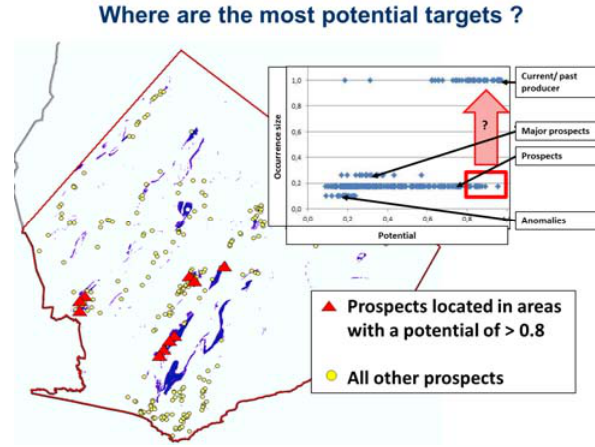
Figure 9. Evaluation of prospects with regard to their potential High potential prospects can clearly be separated from prospects with less potential.